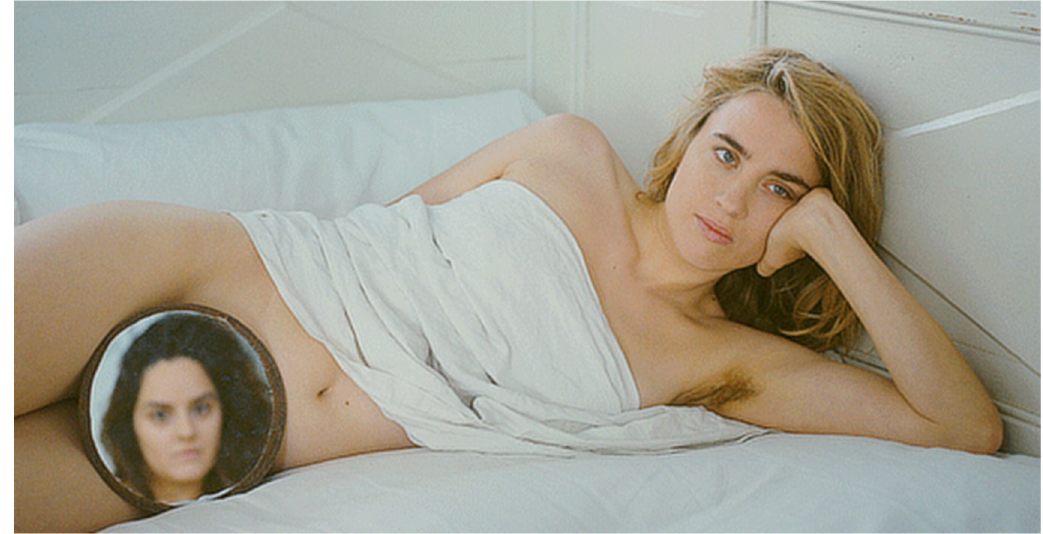
Figure 2. Marianne sketches a self-portrait using a mirror propped against Héloïse’s stomach in Portrait of a Lady on Fire, dir. Céline Sciamma (2019). Screenshot © Lilies Films.